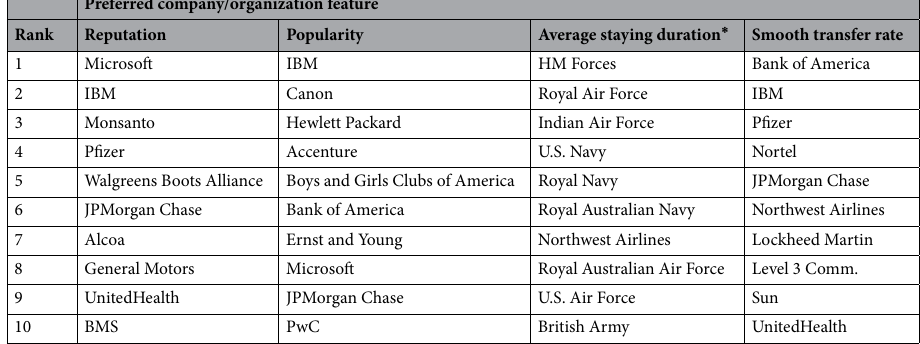
Table 1. Top-10 most frequent recommendations via SSRL. This table reports the most frequently recommended companies or organizations via our SSRL framework, based on different user preferences on the four company-specific features in our evaluation model. *Given that the “average staying duration” is the preferred feature, the top-10 recommendations obtained include many military positions. Military is not